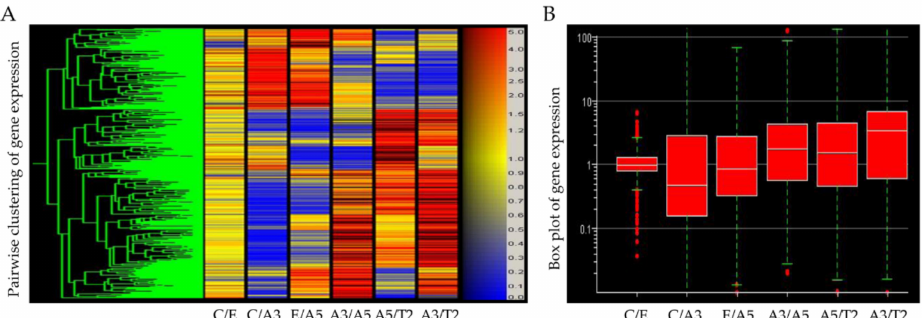
Figure 1. ( A ) Heatmap of Affymetrix array (U133A) data that allows comparing the gene expres- sion of the cell lines derived from the model: MCF-10F/Estrogen (C/E); control/Alpha3 (C/A3); estrogen/Alpha5 (E/A5); Alpha3/Alpha5 (A3/A5); Alpha5/Tumor2 (A5/T2), and Alpha3/Tumor2 (A3/T2) (Reprinted/adapted with permission from Ref. [39]. 2013, Spandidos Publications). The red color indicates a higher expression; blue, a lower expression, and yellow equal expression ( left panel ). ( B ) The gene box plot summarizes the range of differential gene expression in the same pairwise cell line comparisons ( right panel